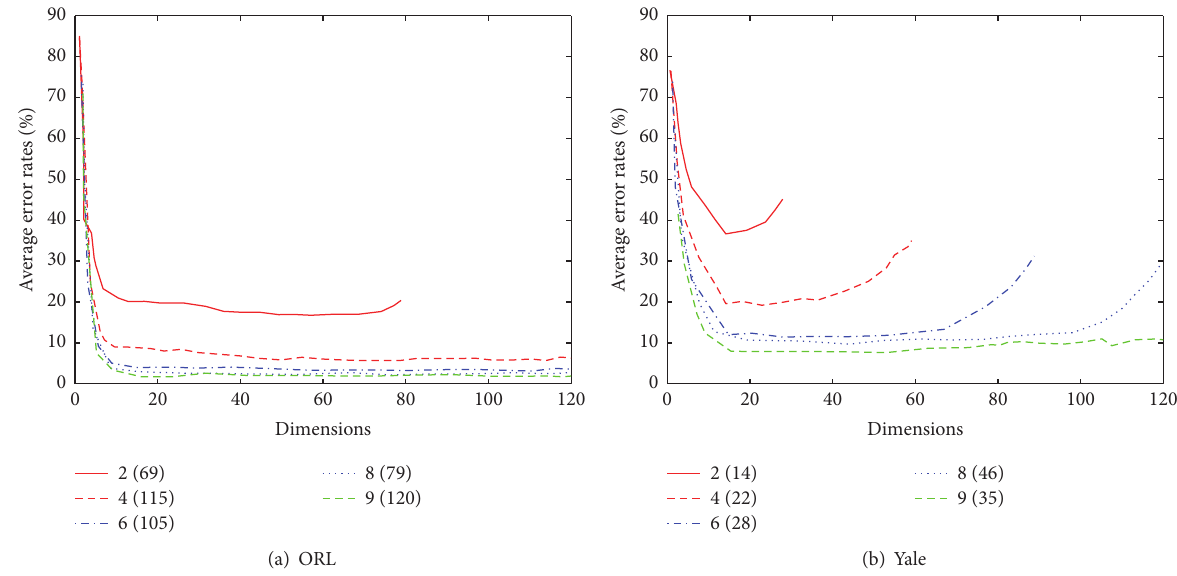
Figure 2: The error rate of the proposed method with the change of